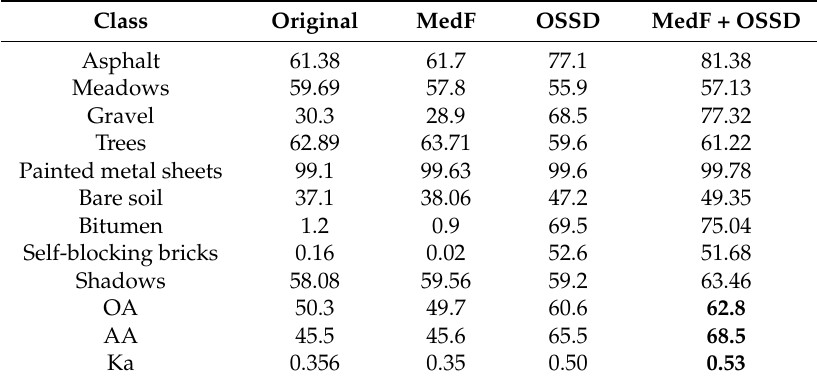
Table 5. Classification accuracies (Pavia University image) in percent (%) for the KNN classifier in the three tests.